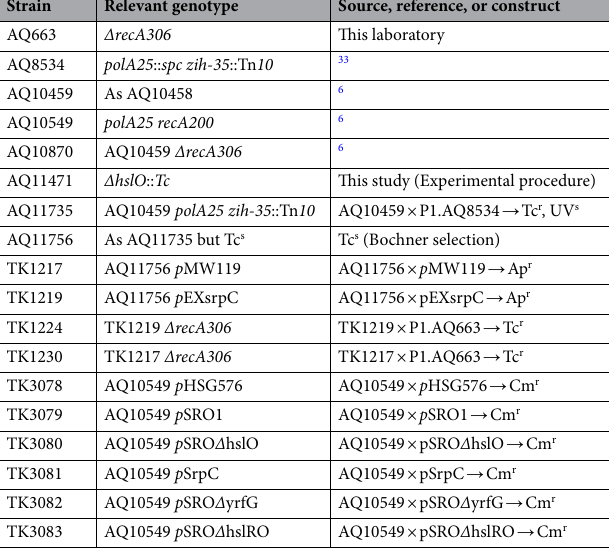
Table 1. Escherichia coli strains used in this study. Tr temperature-resistant growth at 42 °C, Ts temperature- sensitive growth at 42 °C, Tc r , Km r , Cm r , and Ap r denote resistance to tetracycline, kanamycin, chloramphenicol, and ampicillin, respectively, Tc s , Km s , and Cm s denote susceptibility to tetracycline, kanamycin, and chloramphenicol, respectively, UV s sensitive to UV, UV r resistant to UV, Tn transposon. AQ10458 genotype: F-argE3 his-4 leuB-6 proA2 thr-1 thi-1 rpsL31 galK2 lacY1 mtl-1 supE44